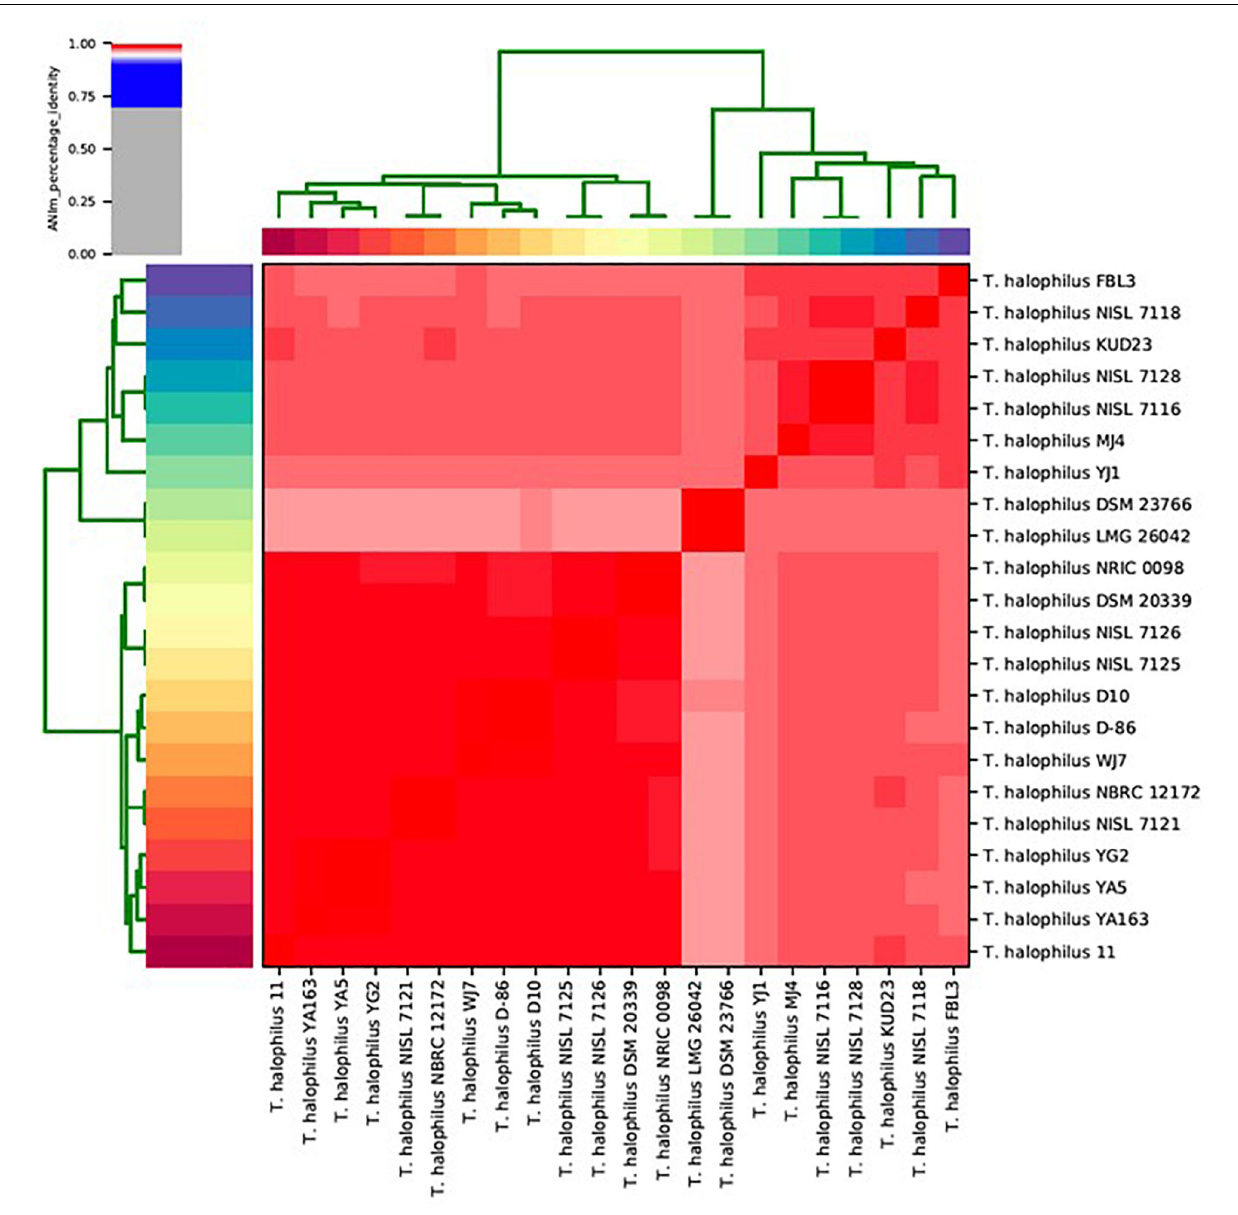
Frontiers in Microbiology |